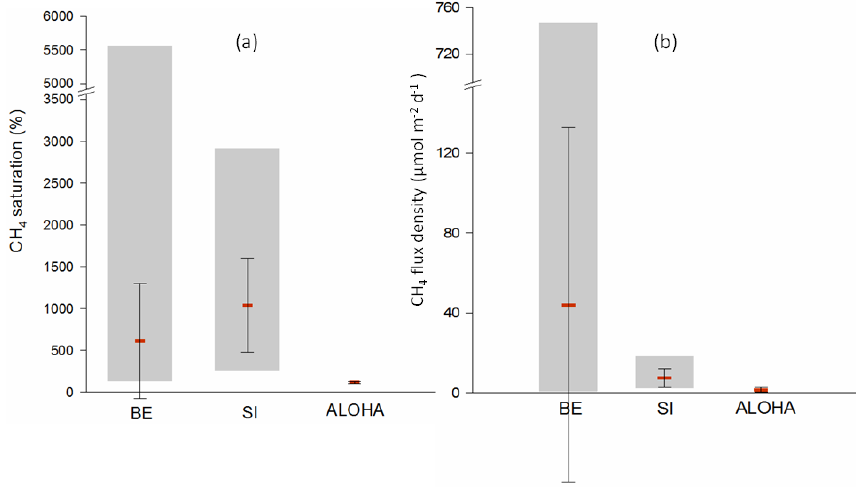
Figure 7. Comparison of surface CH 4 saturations (a) and flux densities (b) from time-series stations of BE, Saanich Inlet (SI) and ALOHA. For the computation of flux density, the equations of Nightingale et al. (2000) and Wanninkhof (2014) were used for SI and ALOHA, respectively. Data in December 2014 at the BE time series station were not included. Please note the break on the y axis for both